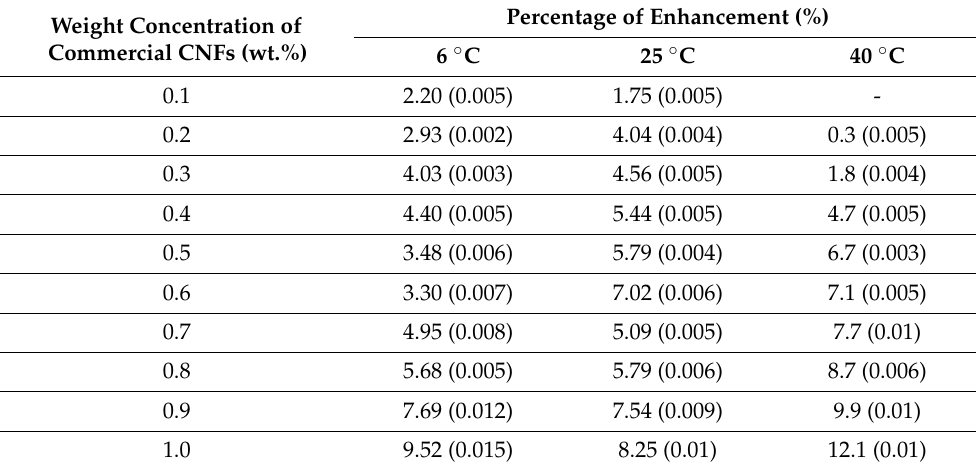
Table 6. Thermal conductivity enhancement of the commercial CNF-based nanofluids without PVP. Weight Concentration of Commercial CNFs